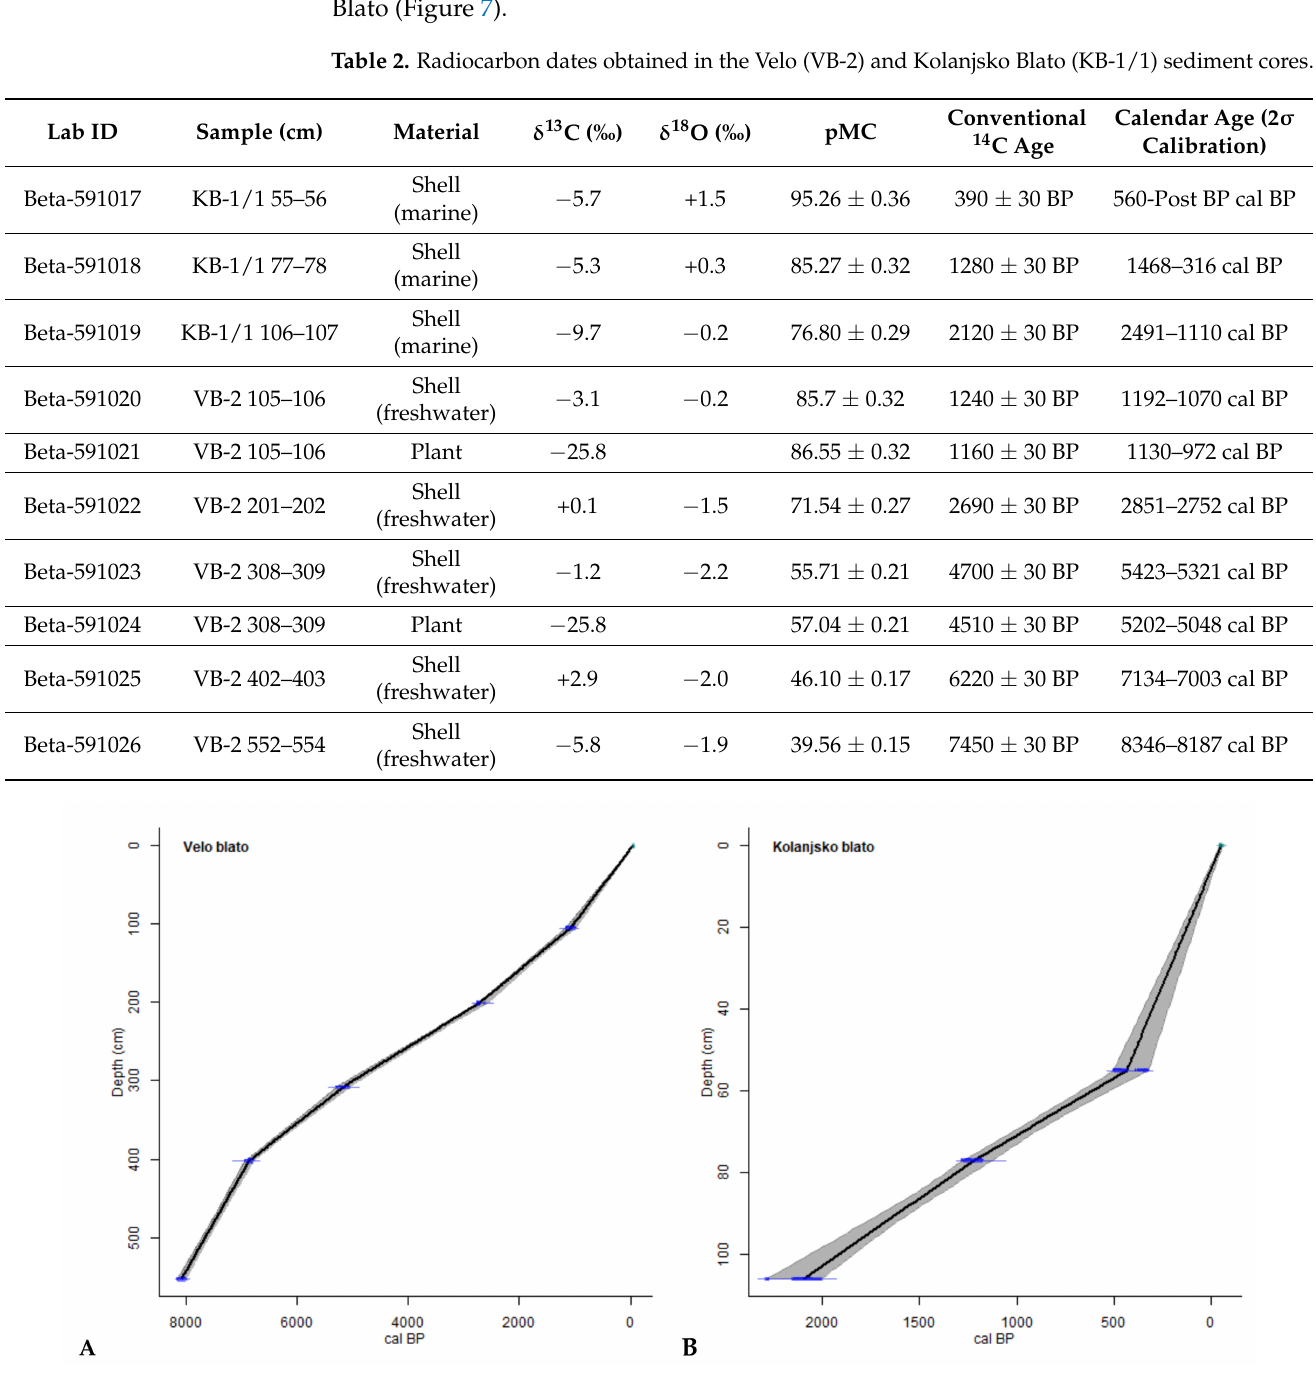
Figure 7. Depth–age models of sediment cores from ( A ) Lake Velo Blato (VB-2) and ( B ) Kolanjsko Blato